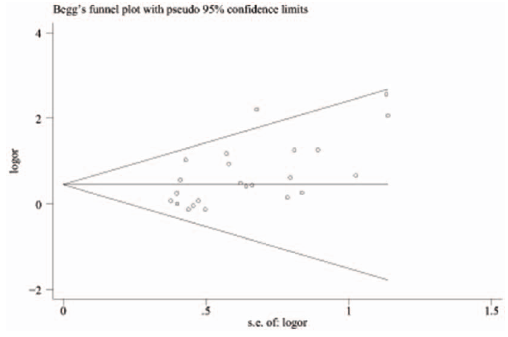
Figure 7. Begg’s funnel plot of publication bias test of all preeclampsia associated with FVL. LogOR means nature logarithm of OR (odds ratio). Horizontal line means the summary estimate, while the sloping lines mean the expected 95% confidence interval.